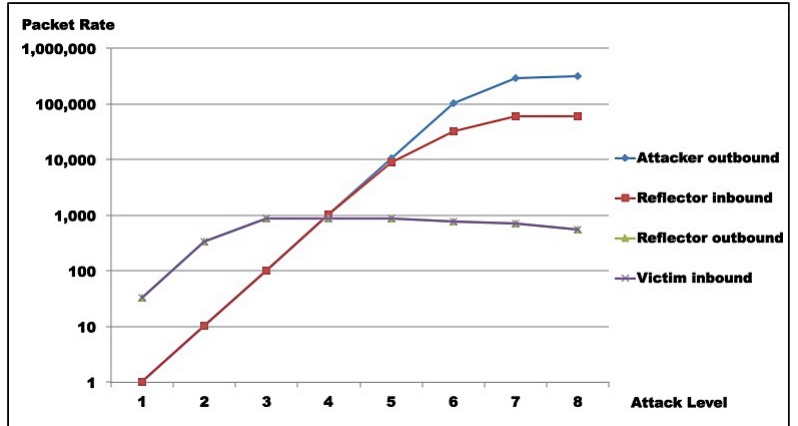
Figure 12. Test 1: Traffic rates (Packet/s).